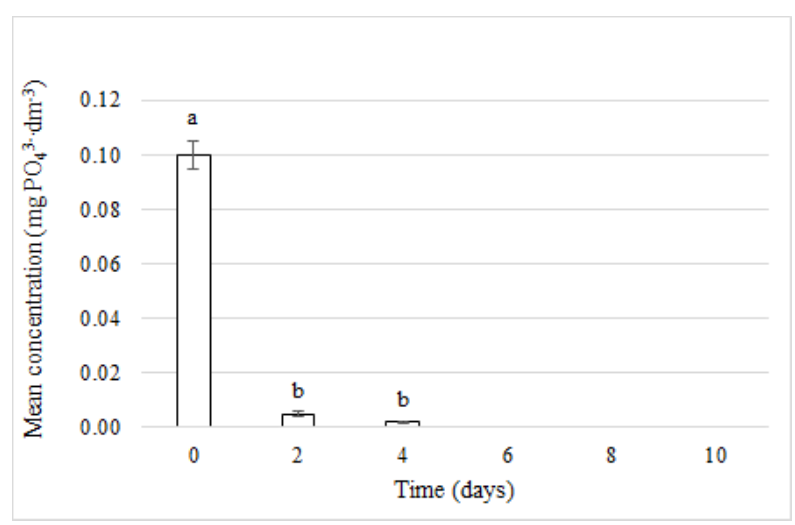
Figure 4. Changes in PO 43− concentration during cultures of Chlorella minutissima in wastewater (mean ± SD; ANOVA F (2, 24) = 2938; p < 0.001; mean over each columns not marked with the same letter is significantly different at p < 0.001).